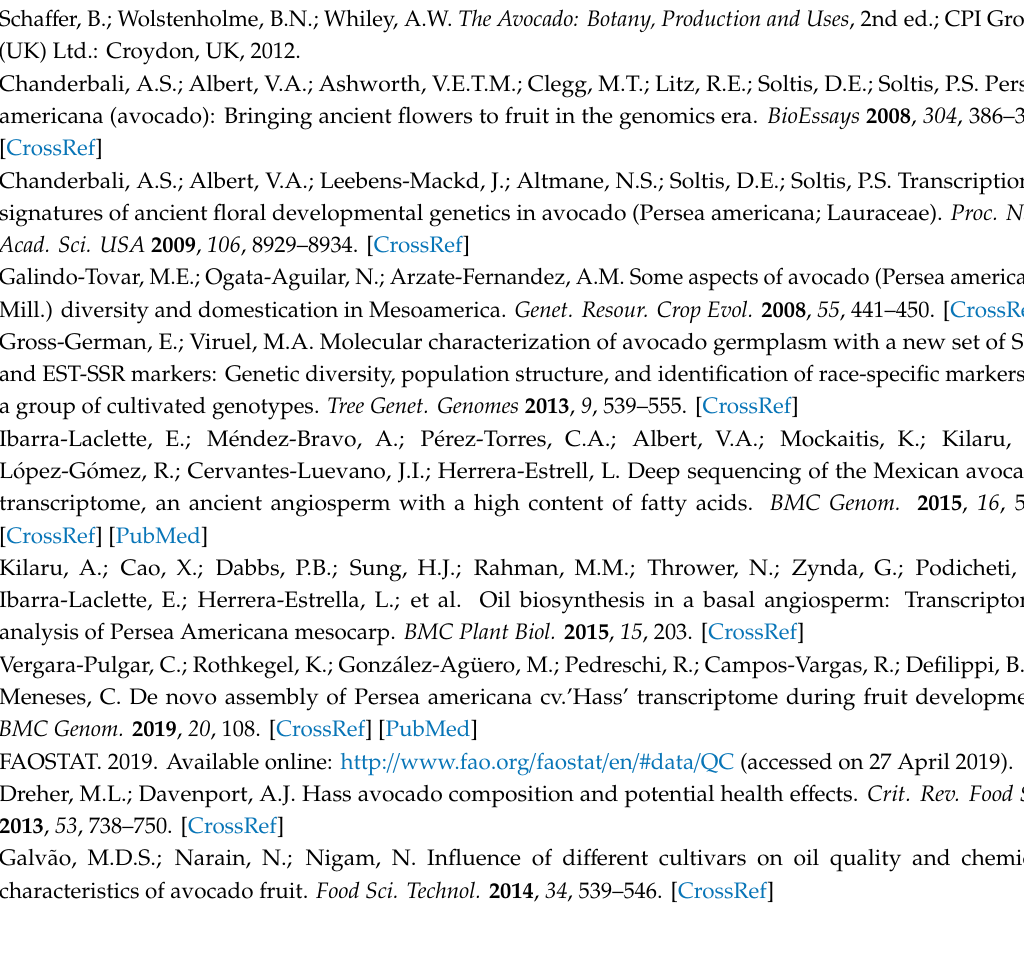
Table S1. Characteristics of six accessions based on transcriptome data; Table S2. Characteristics of GO annotations of assembled avocado unigenes; Table S3. Characteristics of KOG classifications of assembled avocado unigenes; Table S4. Characteristics of KEGG pathways of assembled avocado unigenes; Table S5. Transcription factors identified in the avocado assembly; Table S6. Expression levels (FPKM) of all di ff erentially expressed genes in the avocado assembly; Table S7. Frequencies of di ff erent repeat motifs in EST-SSRs from avocado; Table S8. Characteristics of avocado EST-SSR markers in this study; Table S9. Summary of 100 EST-SSR markers used for amplification; Table S10. Summary of 16 EST-SSRs in 28 avocado accessions; Table S11. The genetic distances among 28 avocado accessions based on 16 polymorphic EST-SSRs from transcriptome data; Additional file 1. BLAST-based coding sequence prediction against NR and Swiss-Prot protein databases; Additional file 2. Coding sequence prediction using